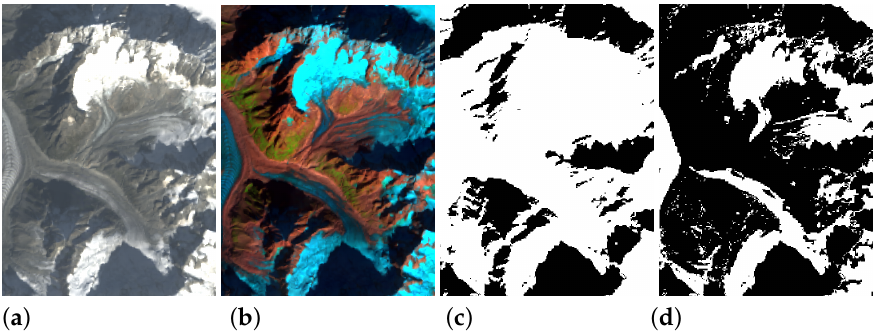
Figure 10. Illustration of a glacier extraction operation over the Mer de Glace. ( a ) TCI of Mer de Glace. ( b ) Green/NIR/SWIR spectral band combination image of Mer de Glace. ( c ) Shadows pixel classification over Mer de Glace, shadows are mapped in black, in white is the resulting mask to apply to remove shadows. ( d ) Glaciers’ pixel classification over the Mer de Glace. Glaciers are mapped in white and used as a mask to isolate pixels of ice and snow for the ice and snow extraction